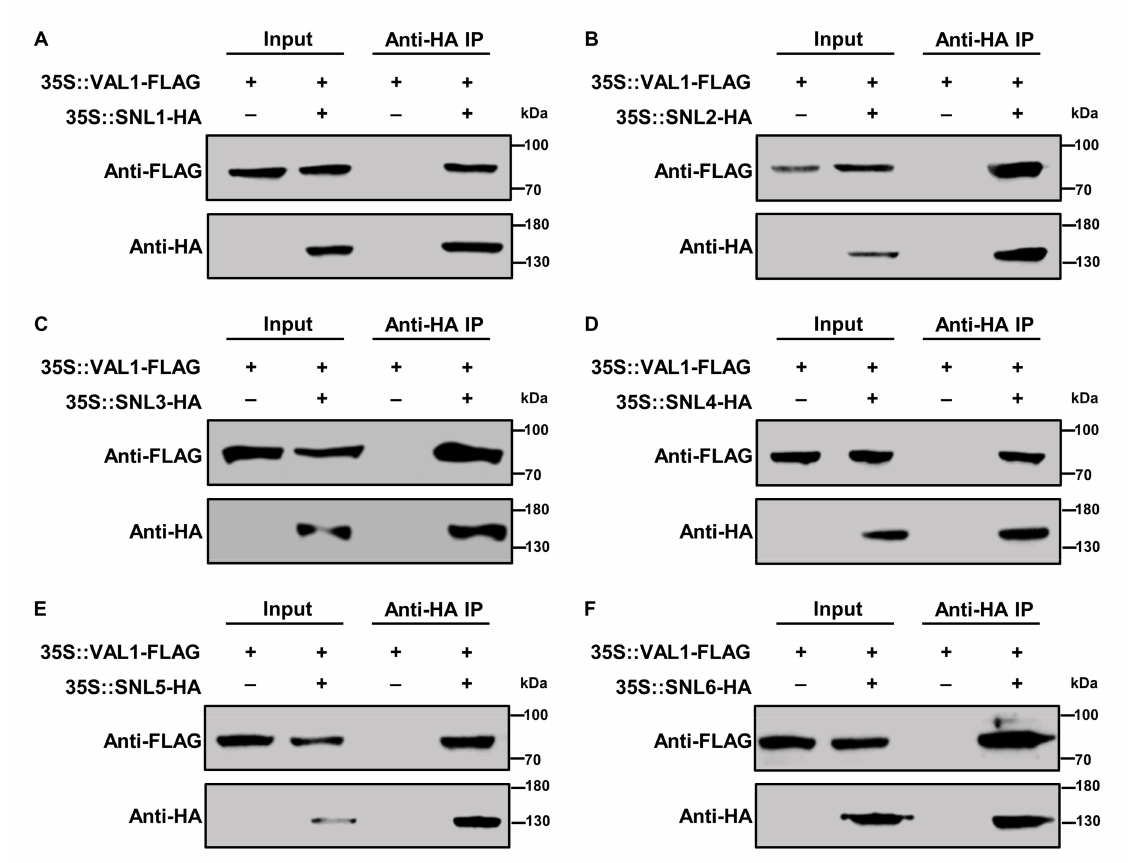
Figure 4. In vivo Co-IP assay validated the interaction between VAL1 and SNLs. ( A – F ) Protein extracts obtained from tobacco leaves infiltrated with Agrobacterium suspensions harboring 35S::VAL1- FLAG and 35S::SNLs-HA constructs. All protein samples were immunoprecipitated (IP) using an anti-HA antibody and then immunoblotted with anti-FLAG. The symbols “ − ”and “+” represent the absence and presence of the corresponding